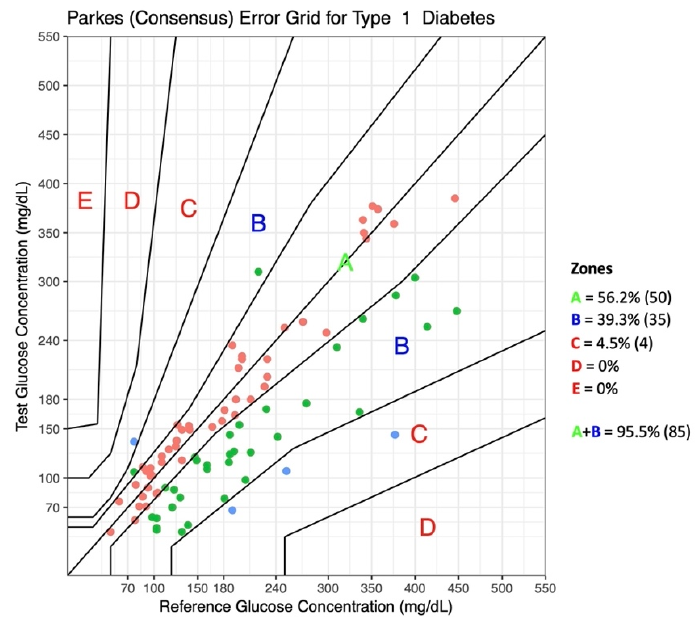
Figure 6. Parkes consensus error grid analysis (EGA) representation with the percentage of values within different zones. The reference glucose values (blood glucose obtained by a portable glucometer) on the x-axis are plotted against the interstitial glucose measurements obtained by the Eversense XL on the y-axis. The different zones designate the magnitude of risk: no effect on clinical action (Zone A); altered clinical action, little or no effect on the clinical outcome (Zone B), altered clinical action, likely to affect the clinical outcome (Zone C); altered clinical action, could have a significant medical risk (Zone D); and altered clinical action, could have dangerous consequences (Zone E). ISO 15197:2013 requires that 99% of the values fall within Zones A + B for a device to be considered accurate.